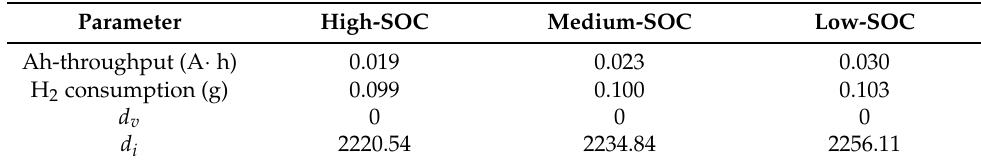
Table 5. Performance parameters of the passive hybrid